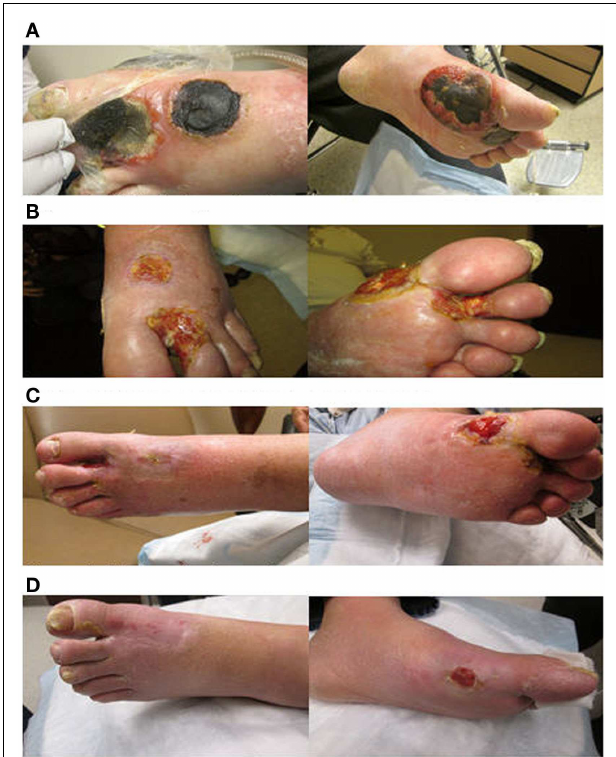
FIGURE 6 |A series of clinical photographs of patient C before treatment (A), 2months after treatment (B), 6months after treatment (C), and 12months after treatment (D)